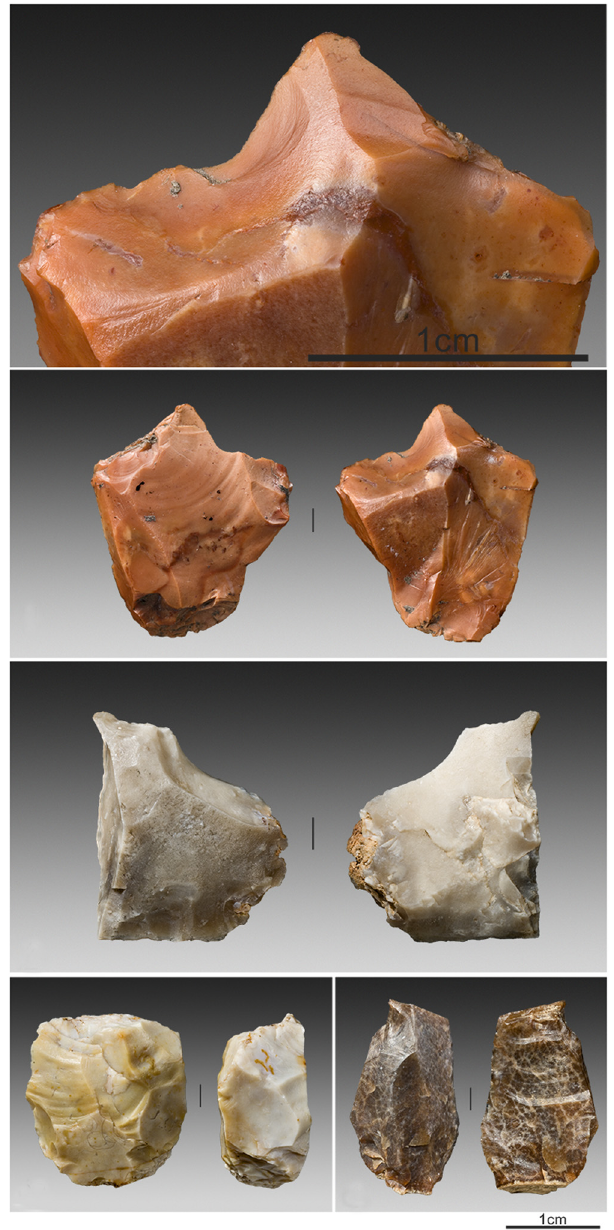
Figure 5: Toledo: artefacts used as tools ( con fi rmed by use - wear analyses ) and as splintered pieces ( used as cores ) . Photo, J. P.